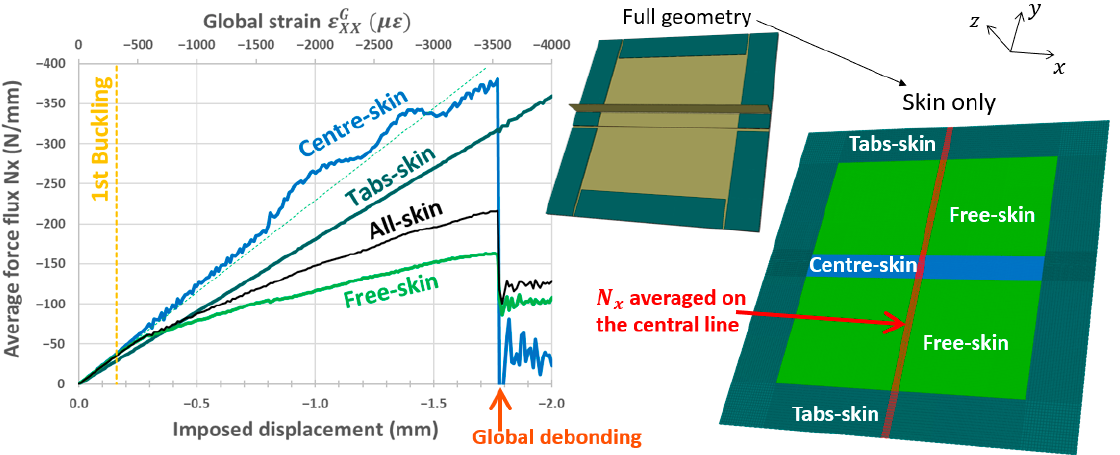
Figure 12. Average flux evolution in the main regions of the skin, during the compression simula- tion, up to the complete debonding of the